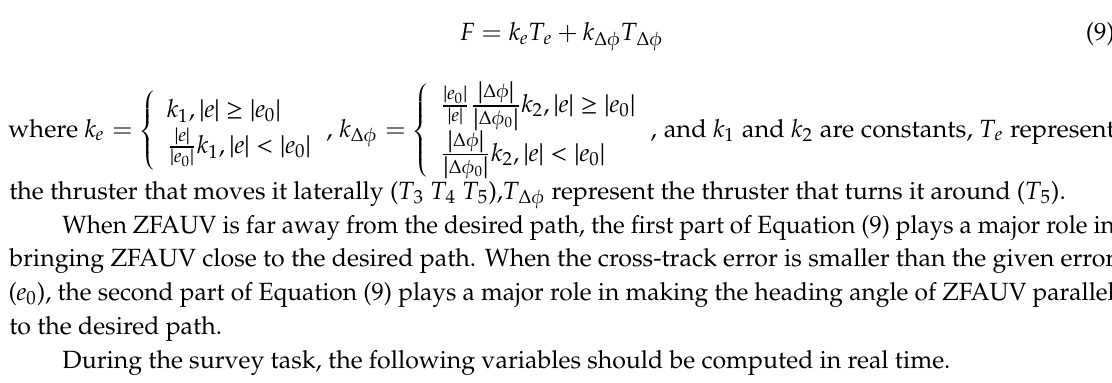
Figure 20. Comparison of different following strategies when deviation occurs.